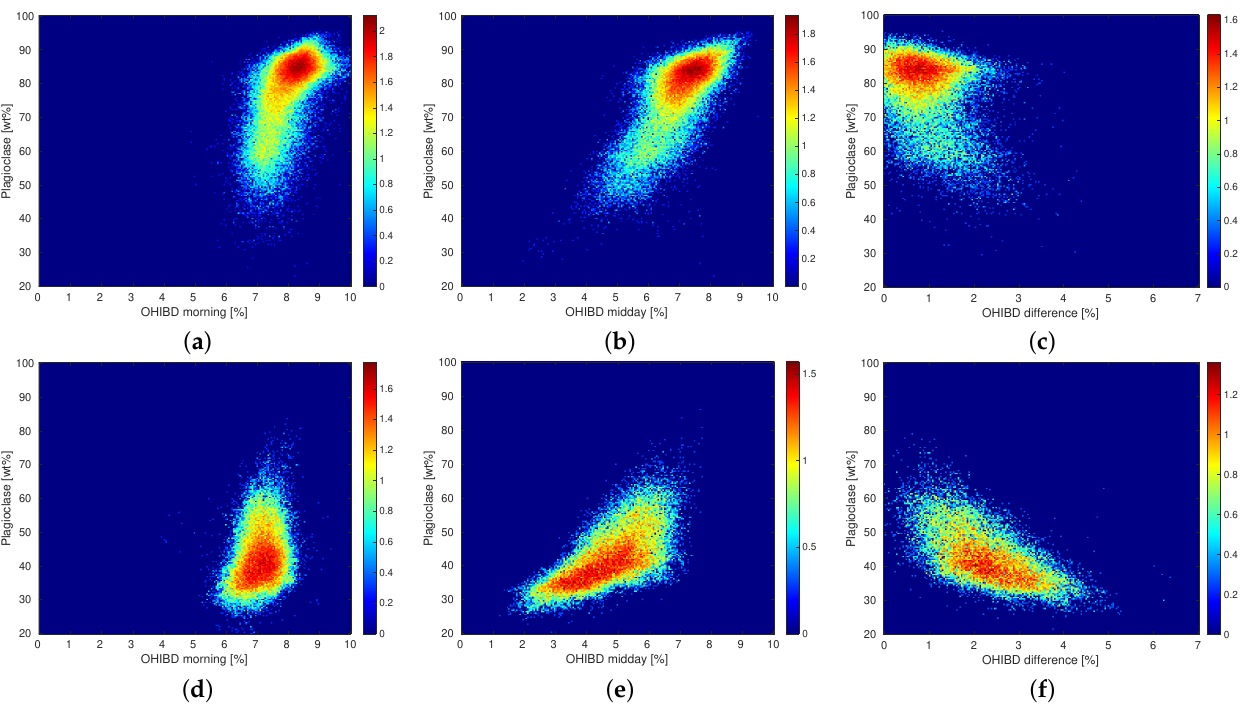
Figure 6. Density plots of plagioclase and OHIBD correlations based on the plagioclase abundance map of Lemelin et al. [58] and the OHIBD maps of Wöhler et al. [5], separately for mare and highland soil. The color bar represents the decadal logarithm of the number of examples at a discrete pixel in parameter space. ( a ) Highland morning ( r = 0.492), ( b ) Highland midday ( r = 0.650), ( c ) Highland difference ( r = − 0.336), ( d ) Mare morning ( r = 0.204), ( e ) Mare midday ( r = 0.649), ( f ) Mare difference ( r = −